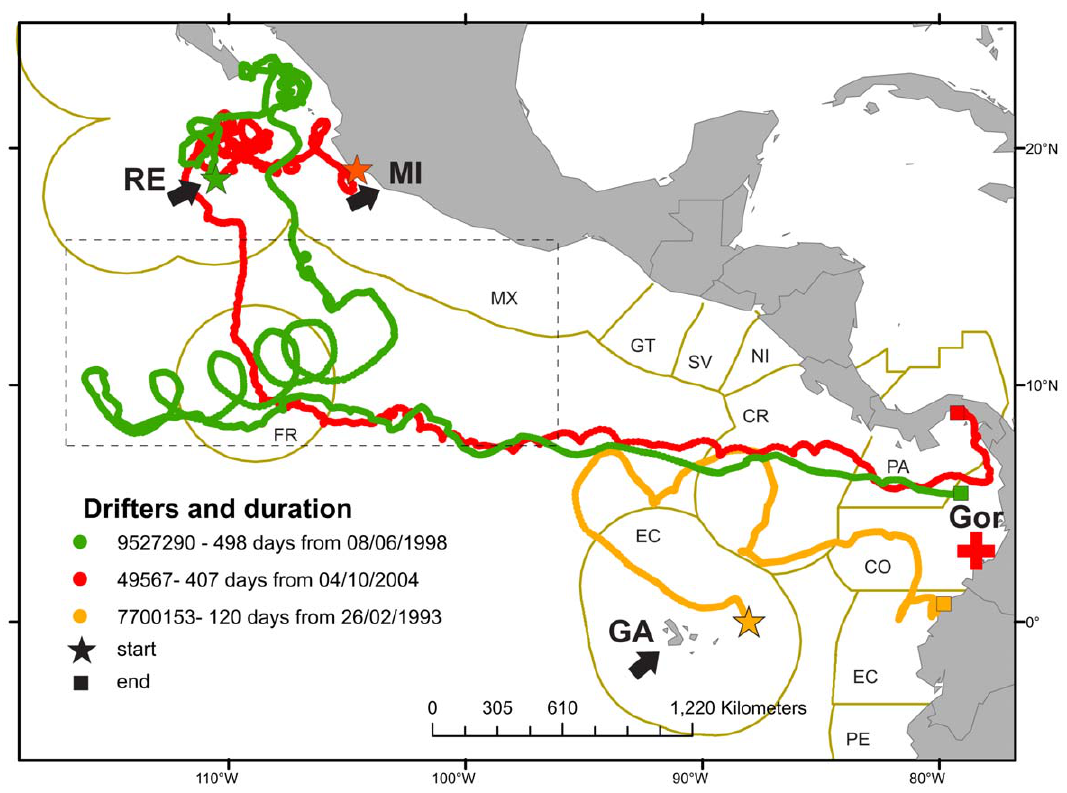
Figure 6. Satellite-tracked drifter buoy trajectories demonstrating potential ocean current pathways linking green turtle breeding areas in the Eastern Pacific with the Gorgona foraging site. Tracks from three drifters deployed near Eastern Pacific breeding ground heading towards the vicinity of the Gorgona study site (red cross). RE=Revillagigedo Islands, Mexico; MI=Michoacan, Mexico; GA=Galapagos Islands, Ecuador; Gor=Gorgona Island, Colombia. Rectangle in broken lines highlight area with frequent eddies provoking recurrent looped tracks with increased speed (about 2X average) but longer entrainment within the current system. Countries’ EEZ boundaries are indicated with two-letter abbreviations. Drifter data from NOAA/AOML Global Lagrangian Drifter Data (http://www.aoml.noaa.gov/envids/gld/krig/parttrk_id_temporal.php).